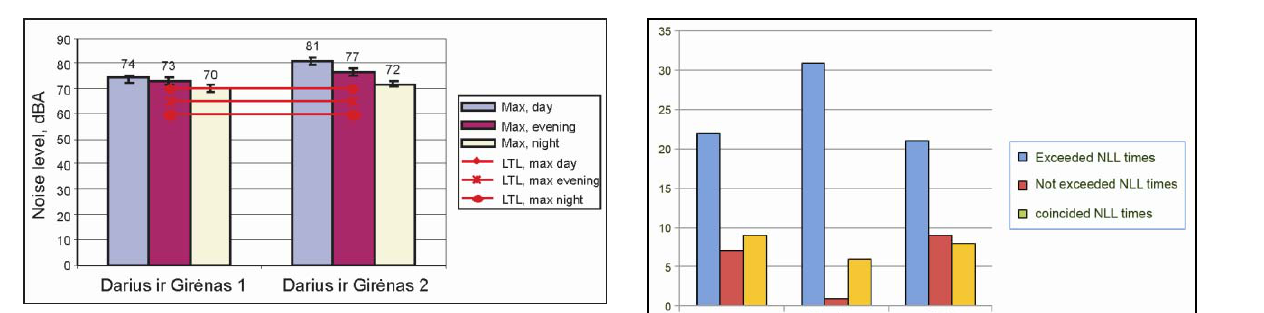
Fig. 27. Dynamics of maximum noise levels in Darius ir Girėnas street within twenty four hours